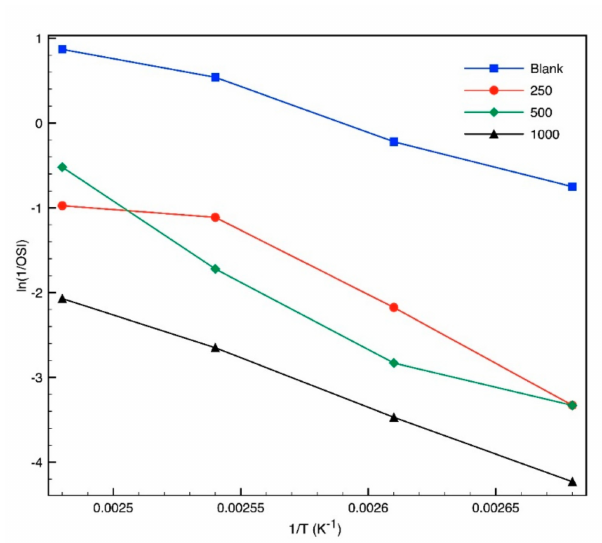
Figure 7. Linearized semilogarithmic inverse OSI vs. inverse absolute temperature equations. Table 5. Thermodynamic parameters of oxidative stability